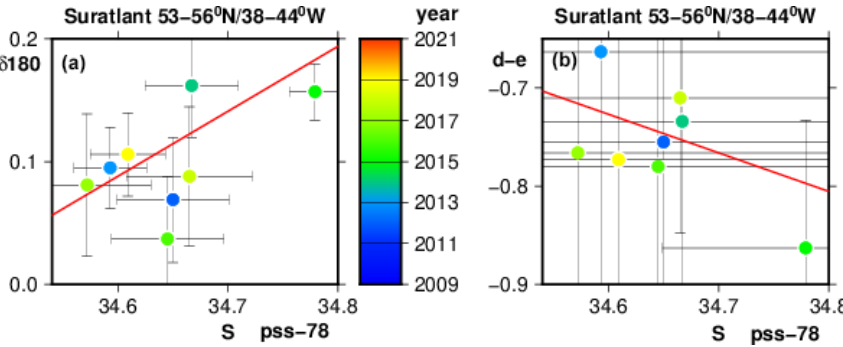
Figure 5. Scatter plots in the southern Irminger Sea and NASPG of annually averaged SURATLANT survey data. Panel (a) presents δ 18 O (‰) versus practical salinity, whereas panel (b) presents d -excess (‰) versus practical salinity. The bars indicate the standard deviation between the individual data that are averaged. The red lines correspond to the average linear relationships in the SURATLANT dataset within 47–55 ◦ N and 30–49 ◦ W, with salinity between 33.1 and 35.5 (see Reverdin et al., 2018a); the red line in the left panel is the same as in Fig.